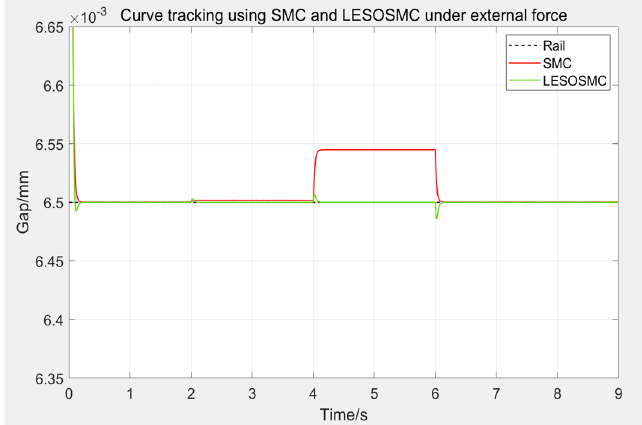
Figure 18. Curve tracking using SMC and LESOSMC under external force.